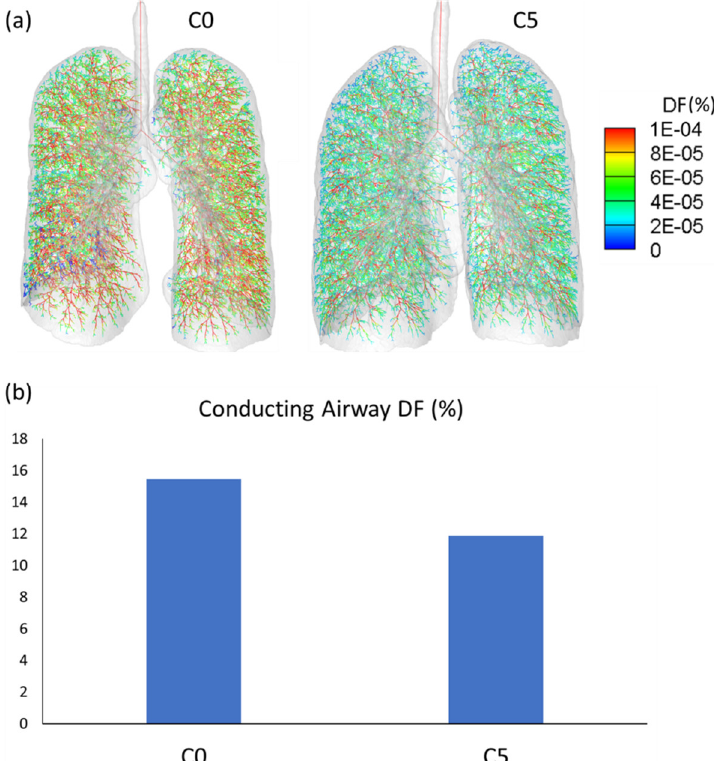
Figure 10. ( a ) Deposition fractions (DF) at each individual airway branch of the entire conducting airway estimated by the 1D particle deposition simulation of the C0 and C5 representative subjects.